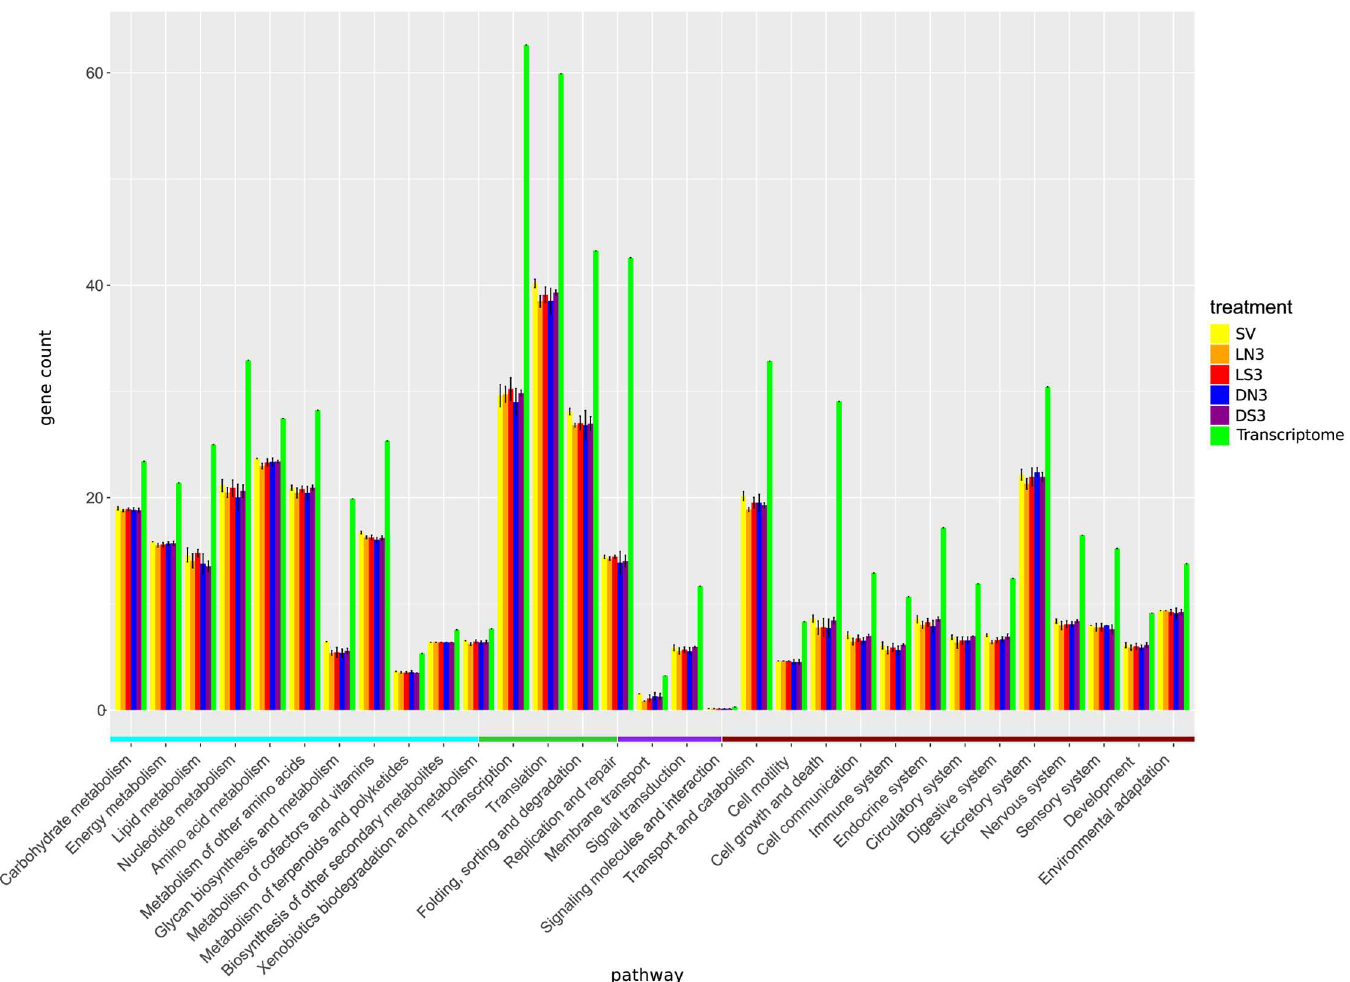
Fig 3. Assignment of protein matches to KEGG pathways B. Assignment of uniquelycountedgenes for time point 3 to KEGG pathway groups of hierarchylevel B. Coloursof pathways on x-axis indicateKEGG hierarchylevel A from Fig 2. The medianover the replicatesfor each treatment is shown with standarddeviation.Treatments are labelledaccordingto the followingscheme: light and silver (LS), light but no silver (LN), samples in darknesswith silver (DS) and in darknessand no silver (DN). Treatment IDs consist of treatment (LS, LN, DS, DN) + samplingday (3). SV representsthe start value and P. malhamensis DS the counts per pathwaycategory for the